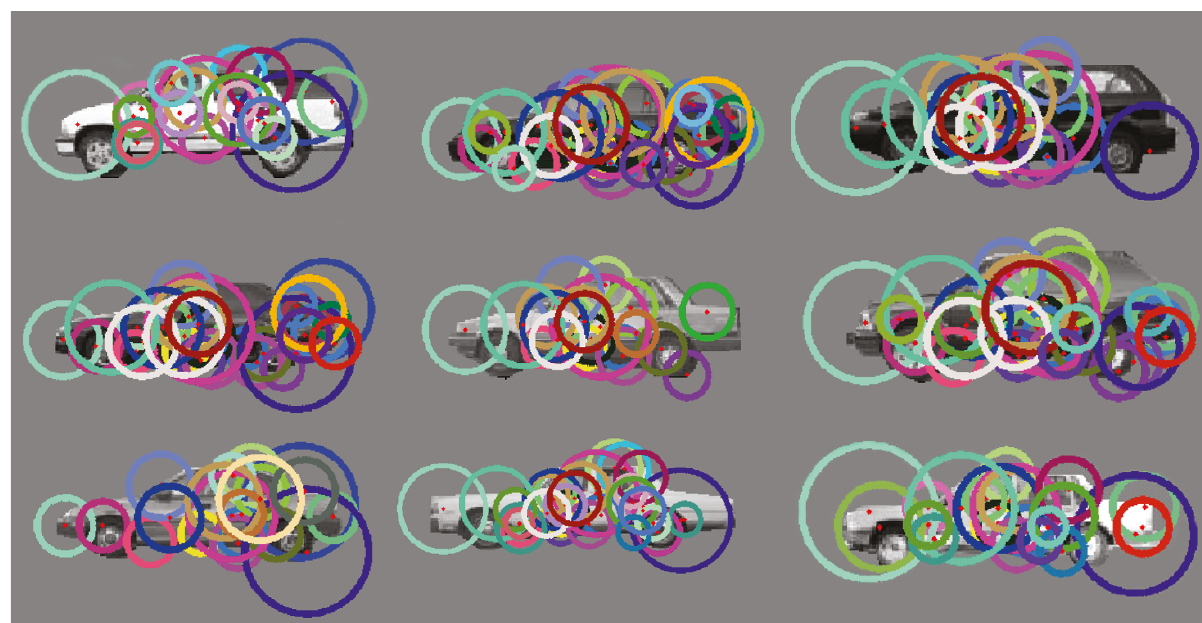
Figure 19: Examples of learned codebook overlaid on exemplars. Di ff erent color represents di ff erent